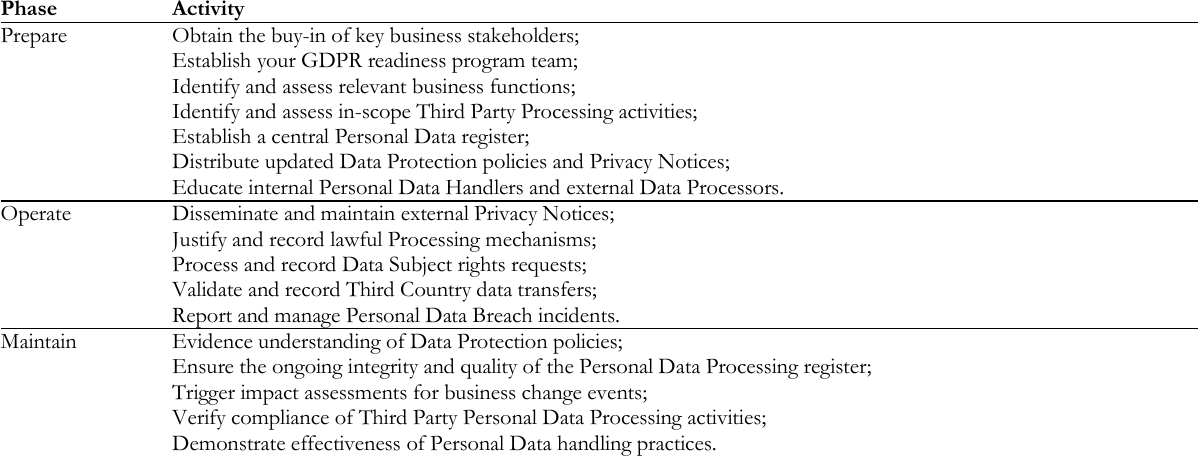
Figure 1. Stages of the GDPR Implementation (IIAAP, 2017) Table 1. Phased activities that support the Accountability Life